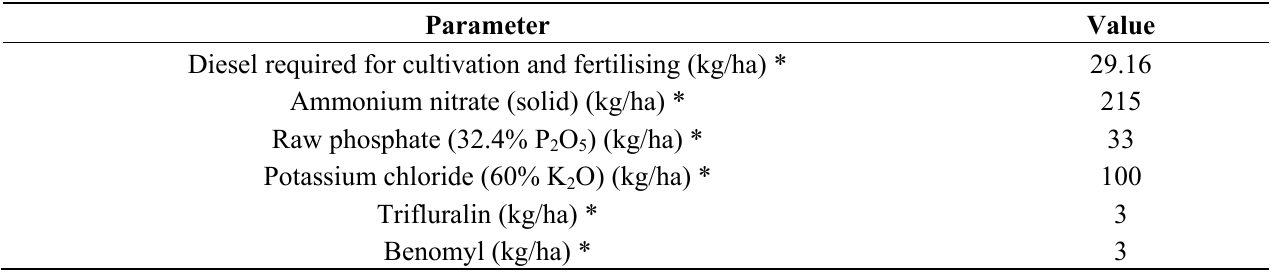
Table A1. Parameters used in the life cycle analysis at the first stage (cultivation and harvesting).